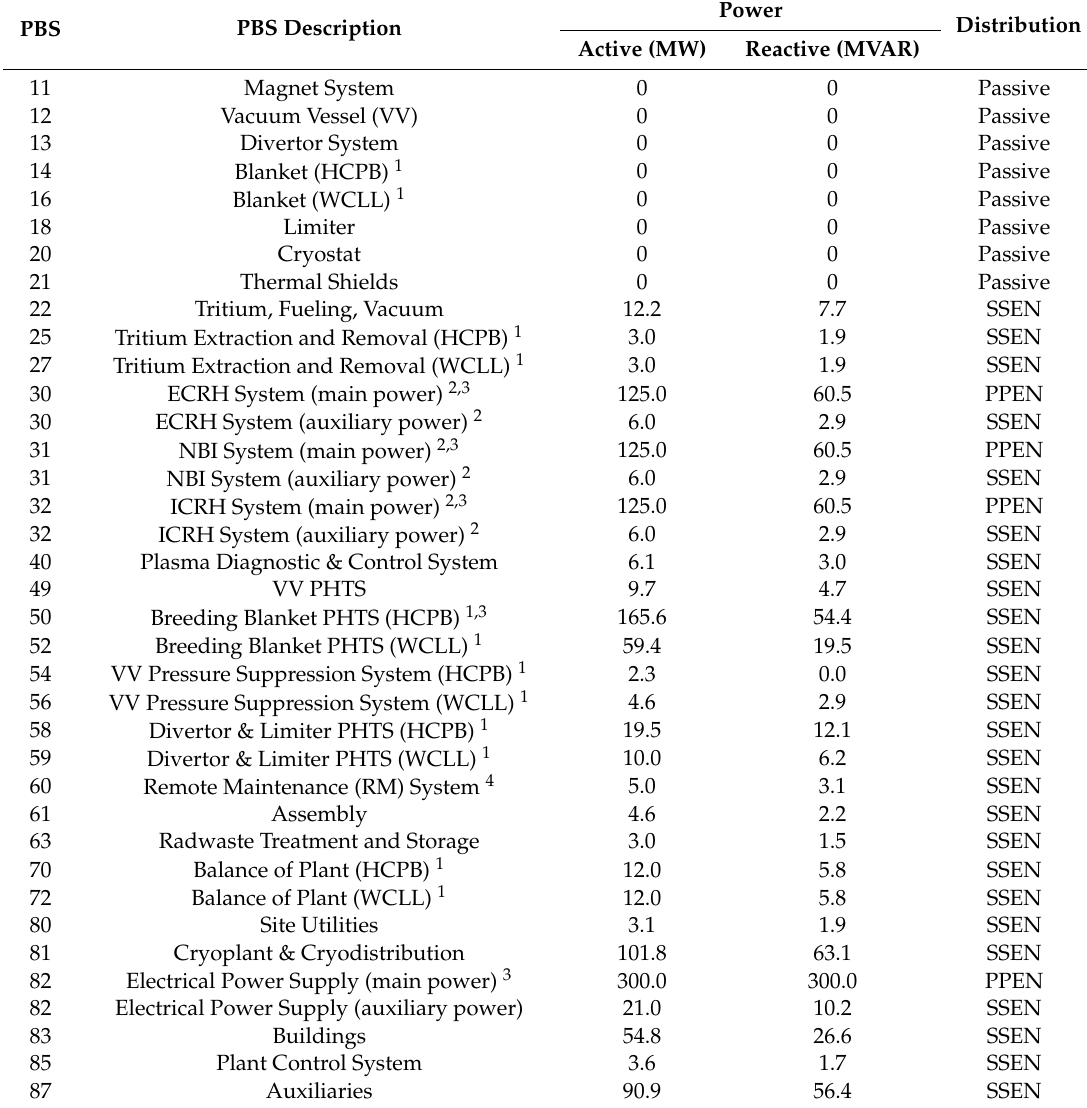
Table 2. EU-DEMO Project Plant Breakdown Structure (PBS) with expected powers and connection to the distribution